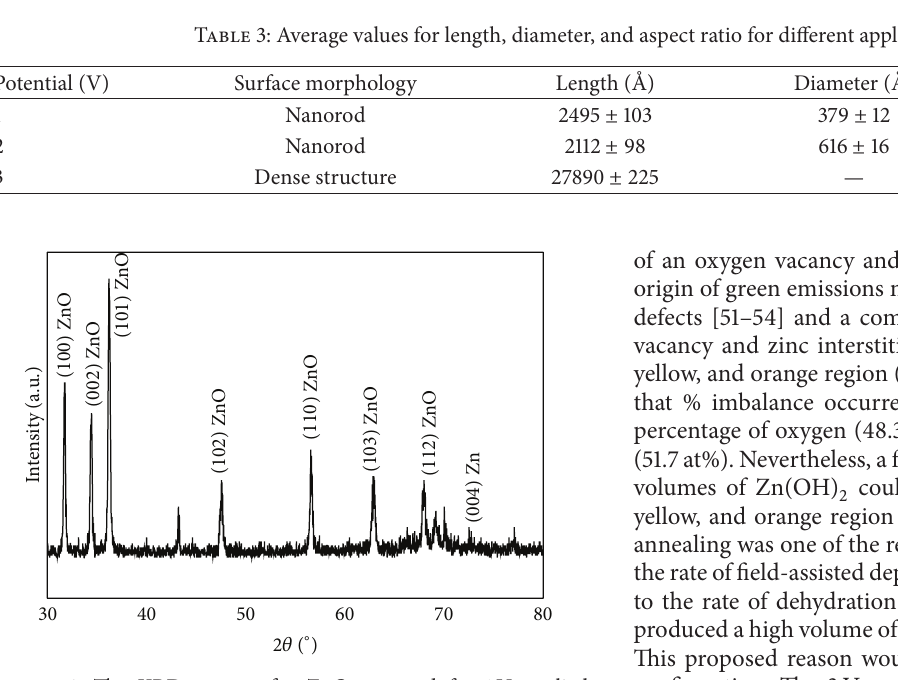
Figure 4: The XRD pattern for ZnO nanorod for 1V applied potential.